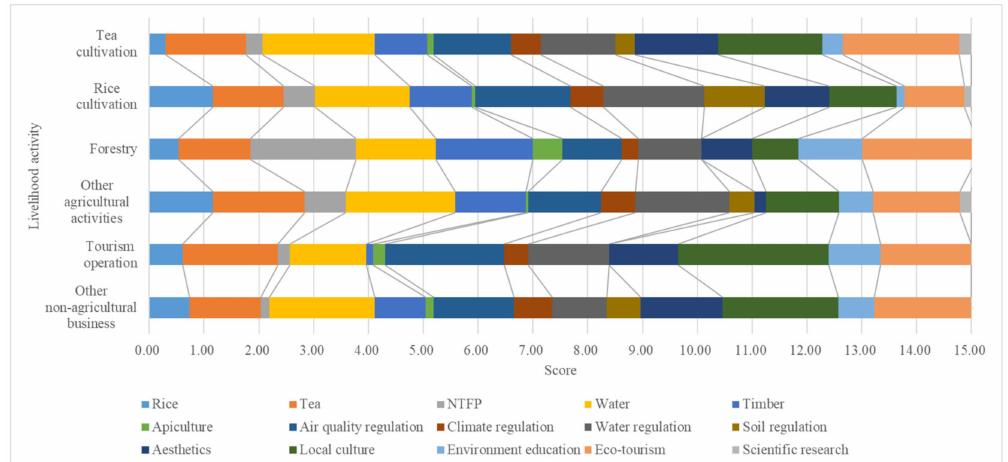
Figure 5. Importance of ecosystem services assessed by households of different livelihood